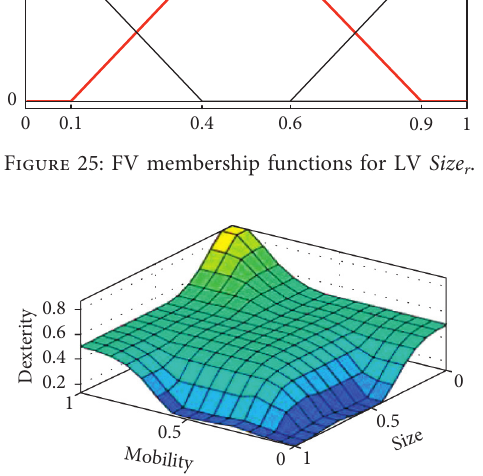
Figure 26: Fuzzy output surface for model M5.